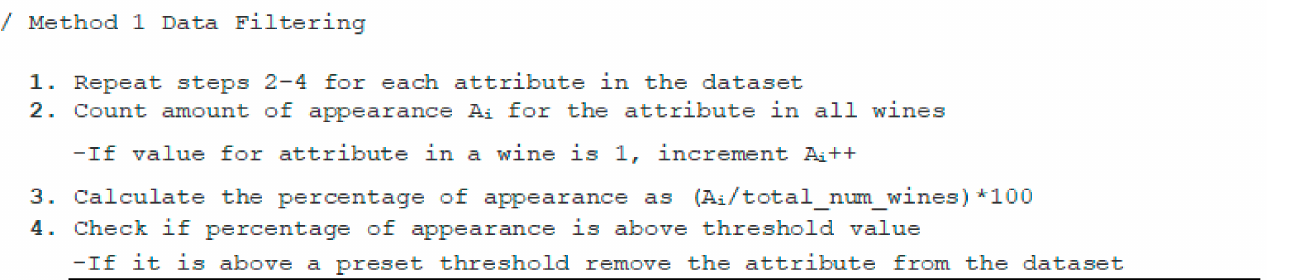
Figure 4. Pseudo code for the filtering method 1: attribute filtration. We utilize A i to account for an attribute (vanilla, cherry, finish, etc.), and we calculate the total appearance of this attribute in the entire dataset. When an attribute appears too often in the dataset, it can skew the results of the clustering algorithm.